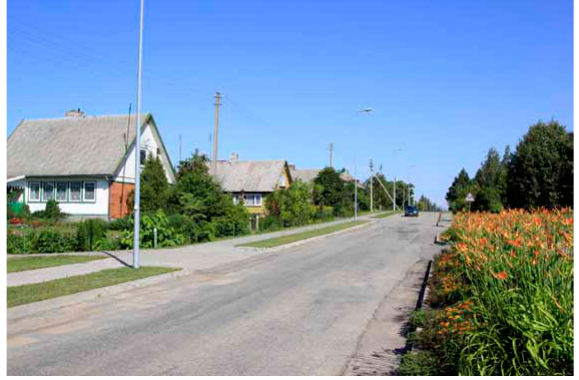
fig. 23. a view of the newly formed Soviet type village. Gable roof architecture and green spaces cotinue the traditions of the lithuanian rural settlements thus creating harmonious spatial structures in villages (the Kaulakiai village in the raseiniai district municipality). E. ramanauskas